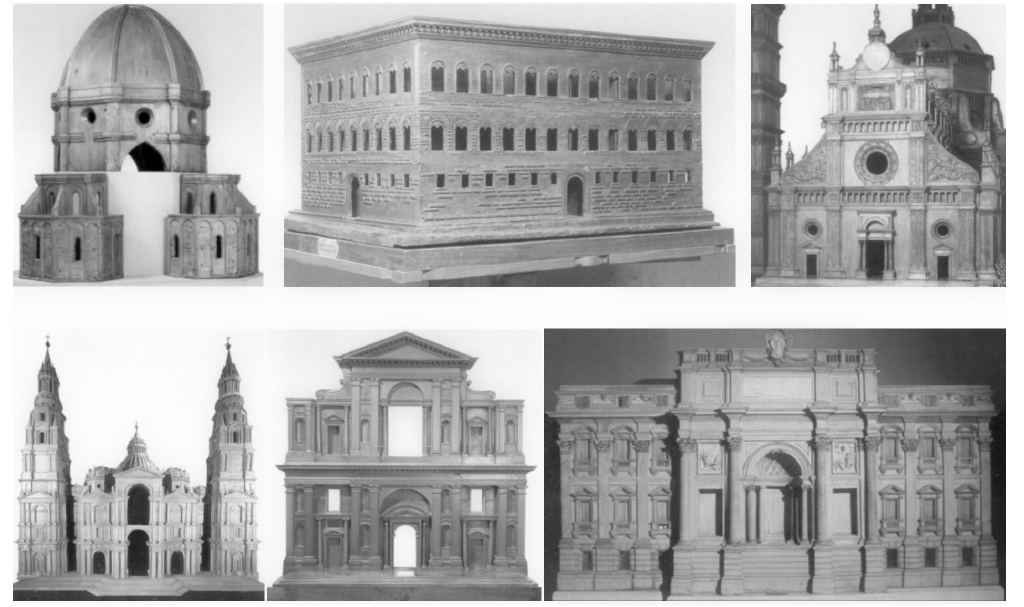
Fig. 4 M. Lo Turco, A